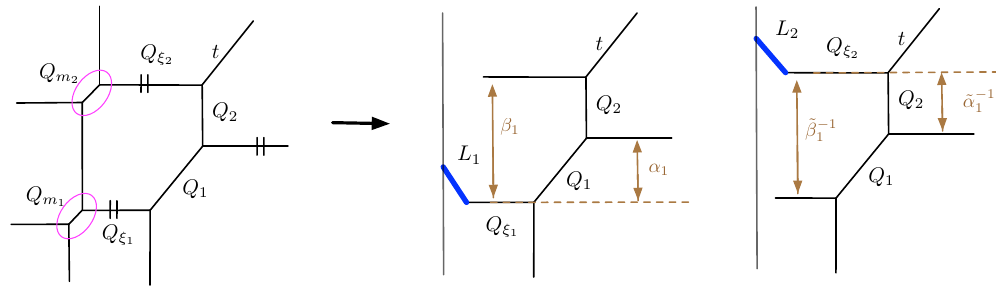
as L 1 , and the one by Higgsing 1